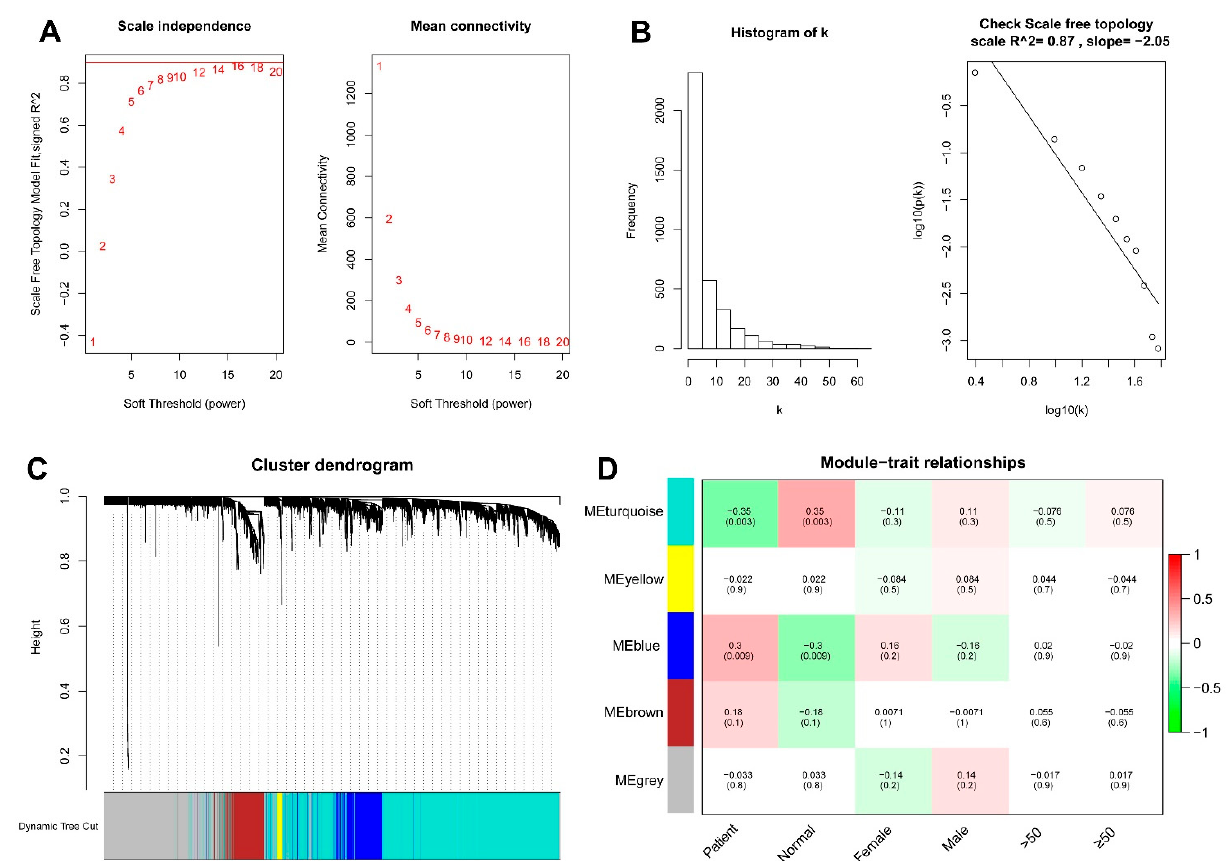
Figure 6. Weighted gene co-expression network analysis of differentially expressed genes between the two clusters. ( A ) Analysis of scale-free fit index and mean connectivity for various soft-thresholding powers ( β value on x -axis). ( B ) Validation of scale-free property of the topology matrix. The variable k refers to the connectivity of each node. ( C ) Cluster dendrogram of co-expressed genes shows the construction of co-expression modules. ( D ) Heatmap of the module–trait relationships with corresponding correlation coefficients and p -values.